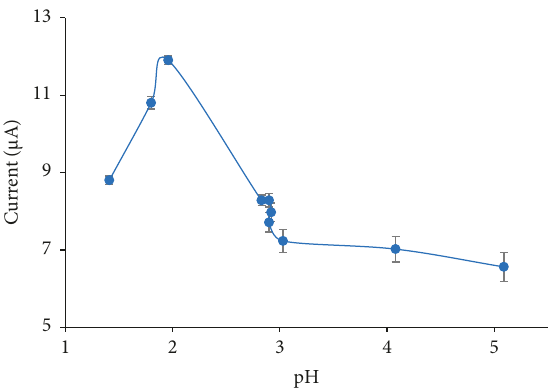
Figure 2: Influence of the solution pH (pH 1.41–9.01) on the Ads- DP-ASVs anodic peak current of DCS (10nM)) at GCE vs. Ag/ AgCl electrode. Scan rate 100mVs − 1 , deposition time 60s and ≈ (cid:29) (cid:29) 0.07mV accumulation potential. Figure 3: Cyclic voltammograms (CVs) of DCS in B-R buffer (pH 2) at scan rates: 20 (A); 50 (B); 70 (C); 90 (D); 100 (E)mV/s at bare GCE vs. Ag/AgCl ≈